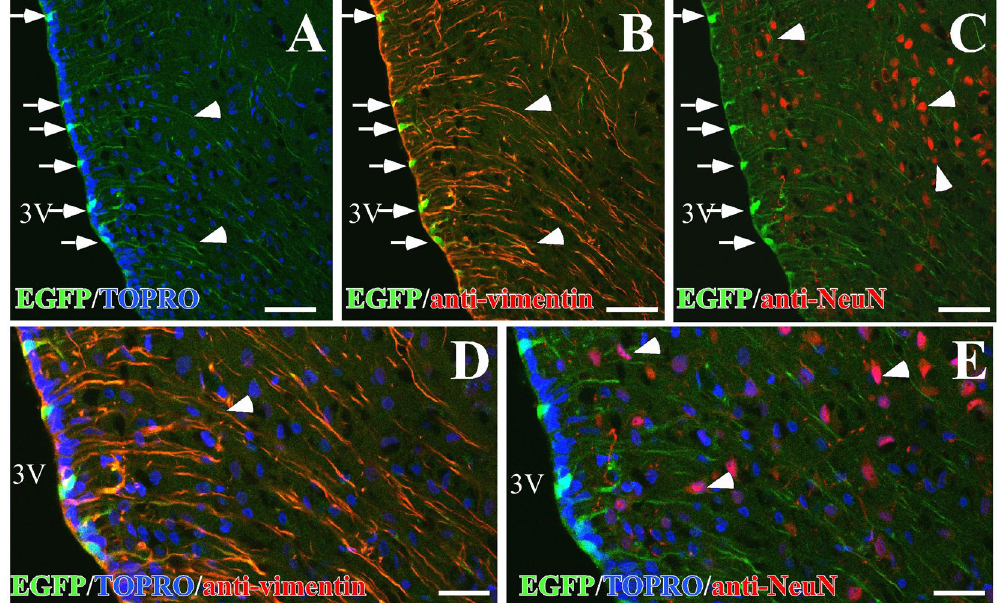
Figure 3. Co-distribution of EGFP and the neuronal marker, NeuN, in the basal hypothalamus. ( A–E ) Representative confocal images of one focal plane using anti-vimentin (red) or anti-NeuN (red) antibodies as well as EGFP fluorescence (green) and TOPRO-3 (blue). ( A ) Image showing EGFP in an α -/ β -tanycyte transition region. ( B ) EGFP detected in the proximal (arrows) and distal processes (arrowheads) of vimentin- positive α -and β -tanycytes. ( C ) The neuronal marker, NeuN, distribution (red), showing the absence of colocalization with EGFP. ( D , E ) High magnification image of the area shown in ( B and C ). Scale bars ( A–C ) 50 μ m; ( D , E ) 25 μ m.